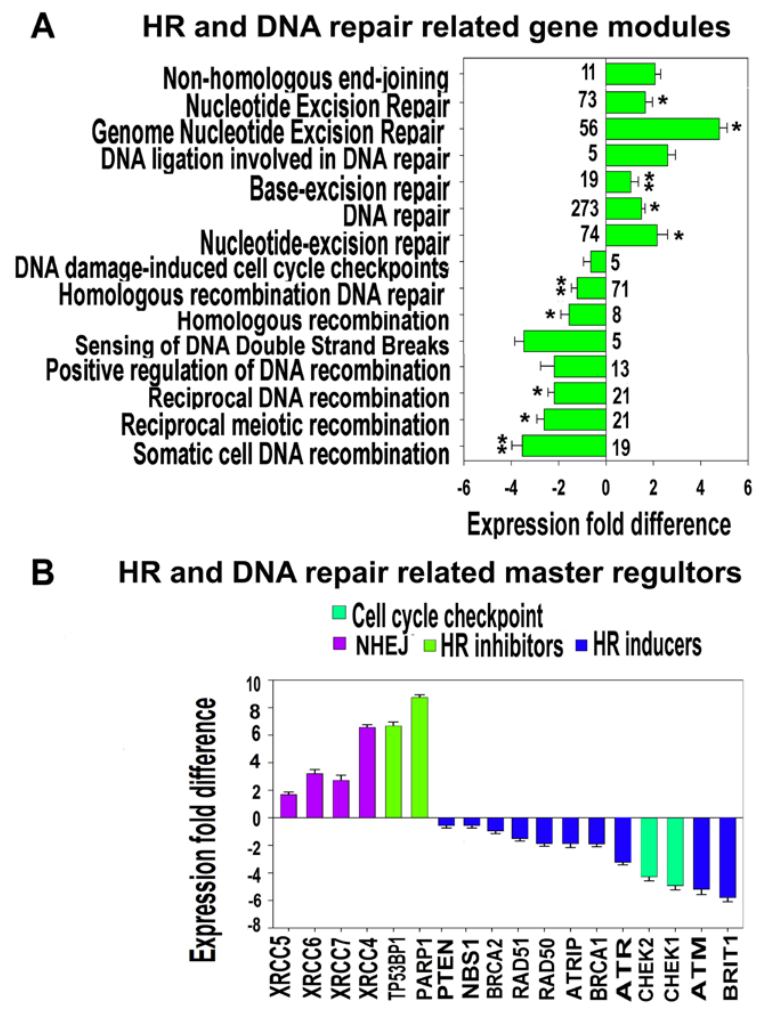
Figure 5. Expression difference of HR and NHEJ related gene modules and master regulators between control eMSC and sublethal heat shock survived progeny (SHS-SP). ( A ) GO biological processes and BioSystems pathways related to DNA repair that are significantly enriched in differentially expressed genes. ** q < 0.001; * q < 0.01; no asterisk– q < 0.01. The numbers near the bars indicate gene number in a module. The data were obtained with 10,888 genes. This figure illustrates the induction of pathways involved in excision repair and the impairment of pathways involved in recombination and DNA damage sensing and checkpoints. ( B ) Expression difference of HR and NHEJ in SHS-SP vs. control eMSC.